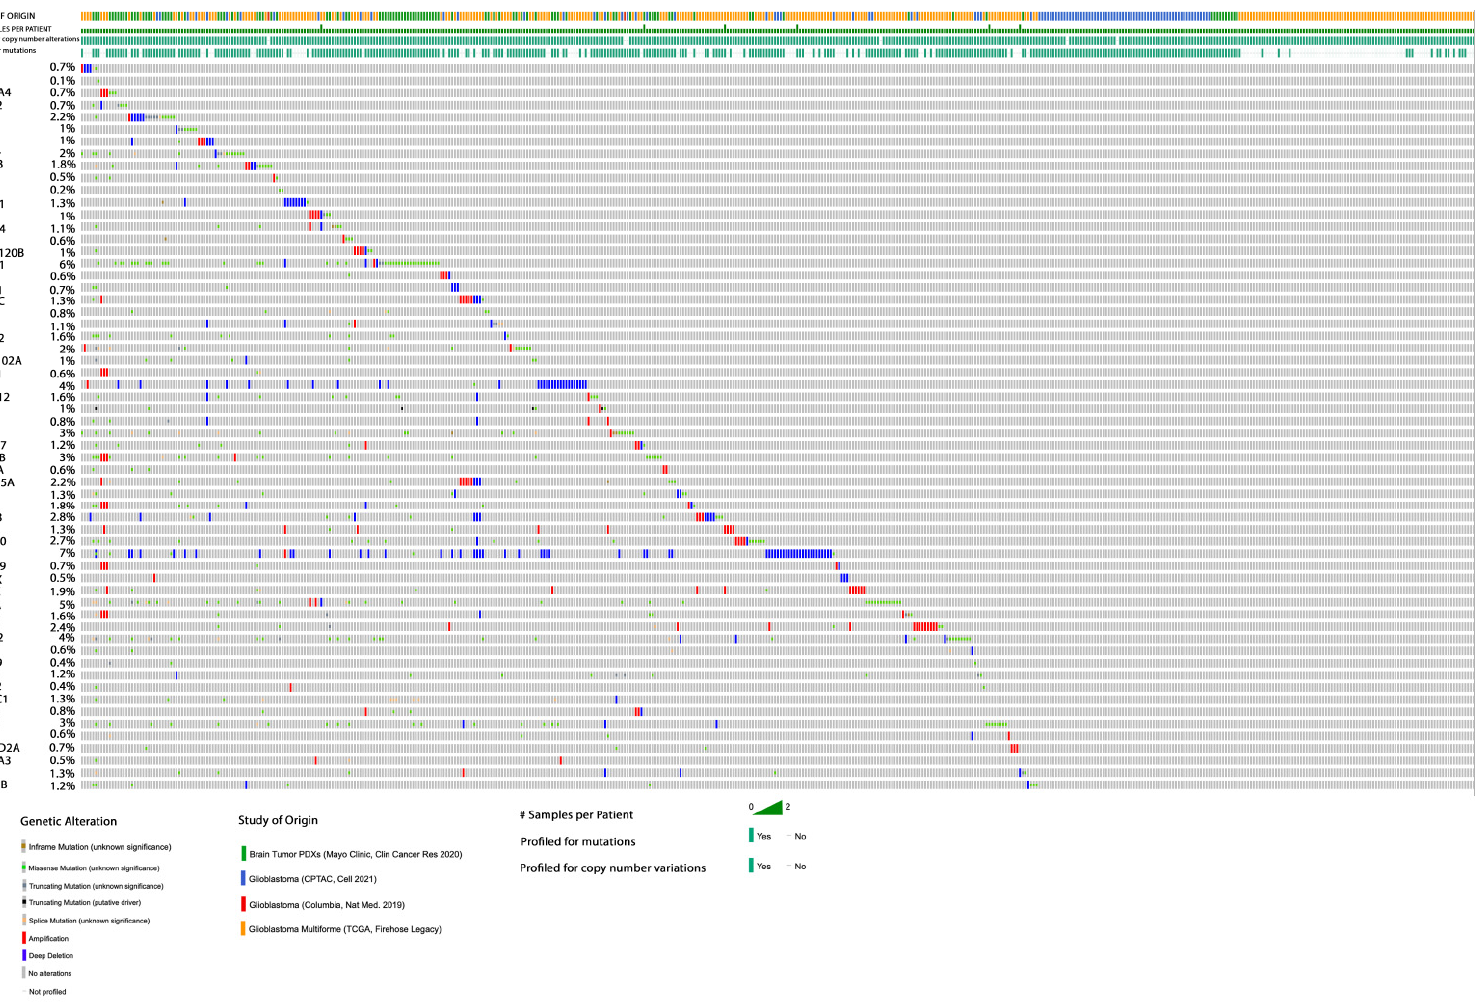
Figure 9. The percentage frequency of mutations in glioblastoma TCGA data for the 60 genes identified via ANNOVAR from the five aggressive glioblastoma samples studied herein. These genes harbored somatic alterations that were both putative deleterious and rare in the general population.